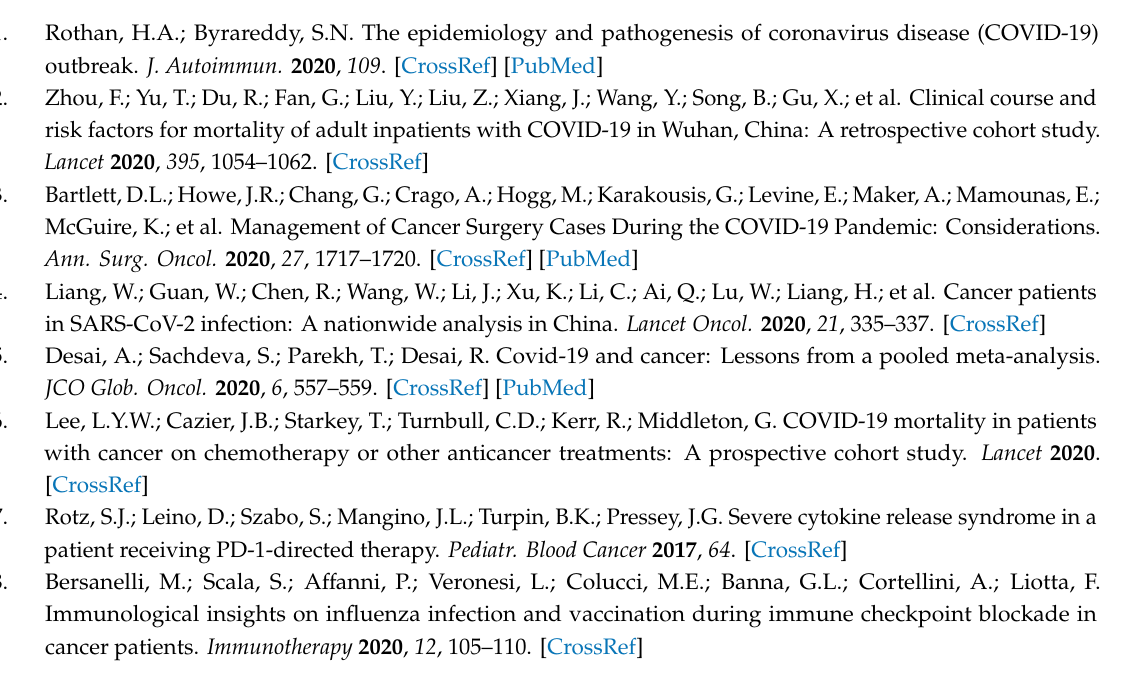
Table S1: Classification of healthcare-workers’ cohort. Table S2: Characteristics of CyTOF cancer patients’ samples. Table S3: The antibody panel used for CyTOF. Table S4: The definition of immune cells based on surface